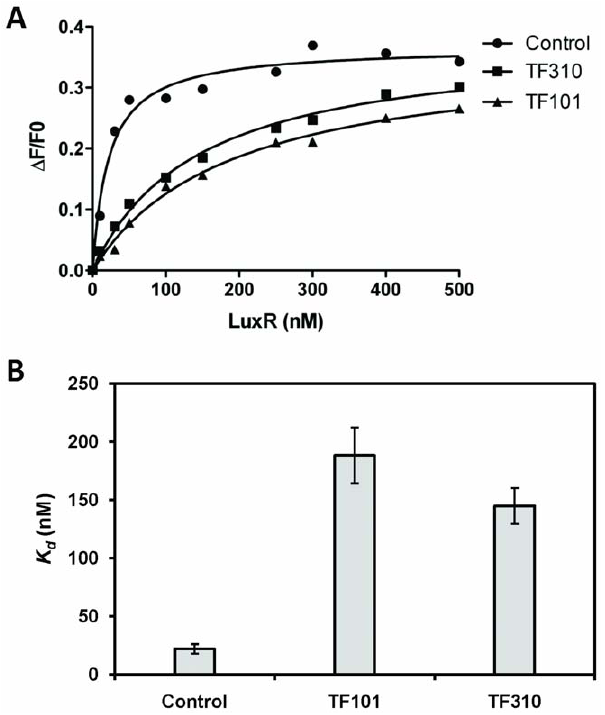
Figure 4. LuxR DNA binding with and without the thiophe- nones (10 m M). A. The fractional change in anisotropy, D F/F o , is plotted against the concentration of purified LuxR. B. K d values are calculated as the half-maximal fractional change in fluorescence anisotropy.